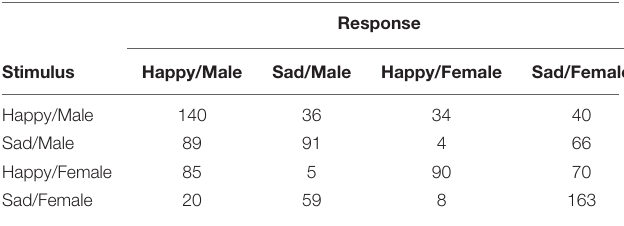
TABLE 1 | Data from a simulated identification experiment with four face stimuli, created by factorially combining two levels of emotion (happy and sad) and two levels of gender (male and